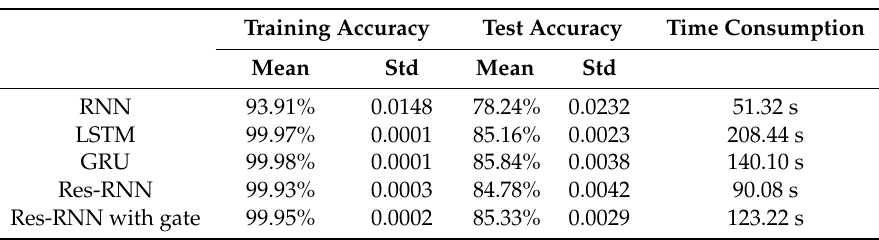
Table 2. Performance of the RNN [9], LSTM [16] and GRU [17], Res-RNN and Res-RNN with gates on the Internet movie database (IMDB) in 20 epochs.